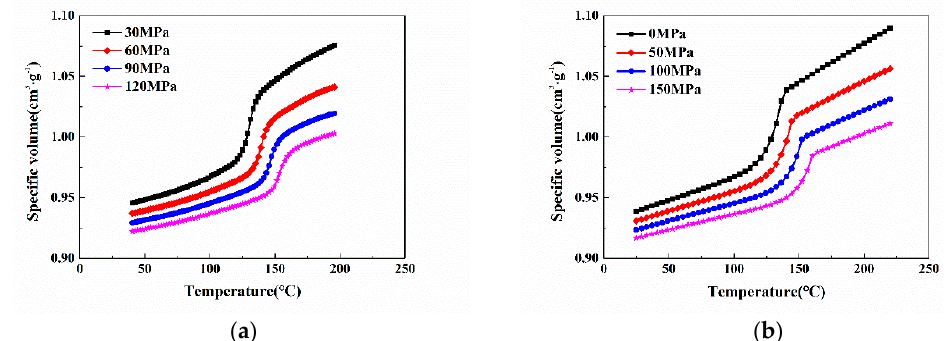
Figure 3. PVT performance of modified PP: ( a ) PVT curve of modified PP; ( b ) fitted PVT curve of modified PP.